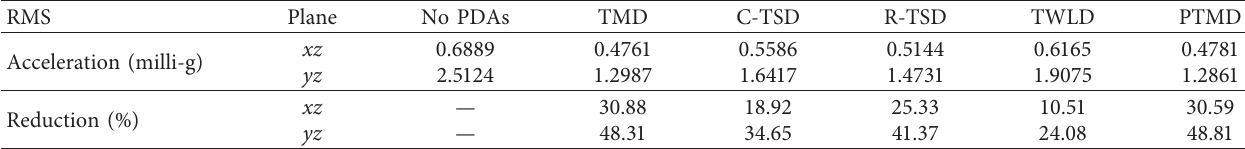
Table 21: Along-wind RMS accelerations at z � H